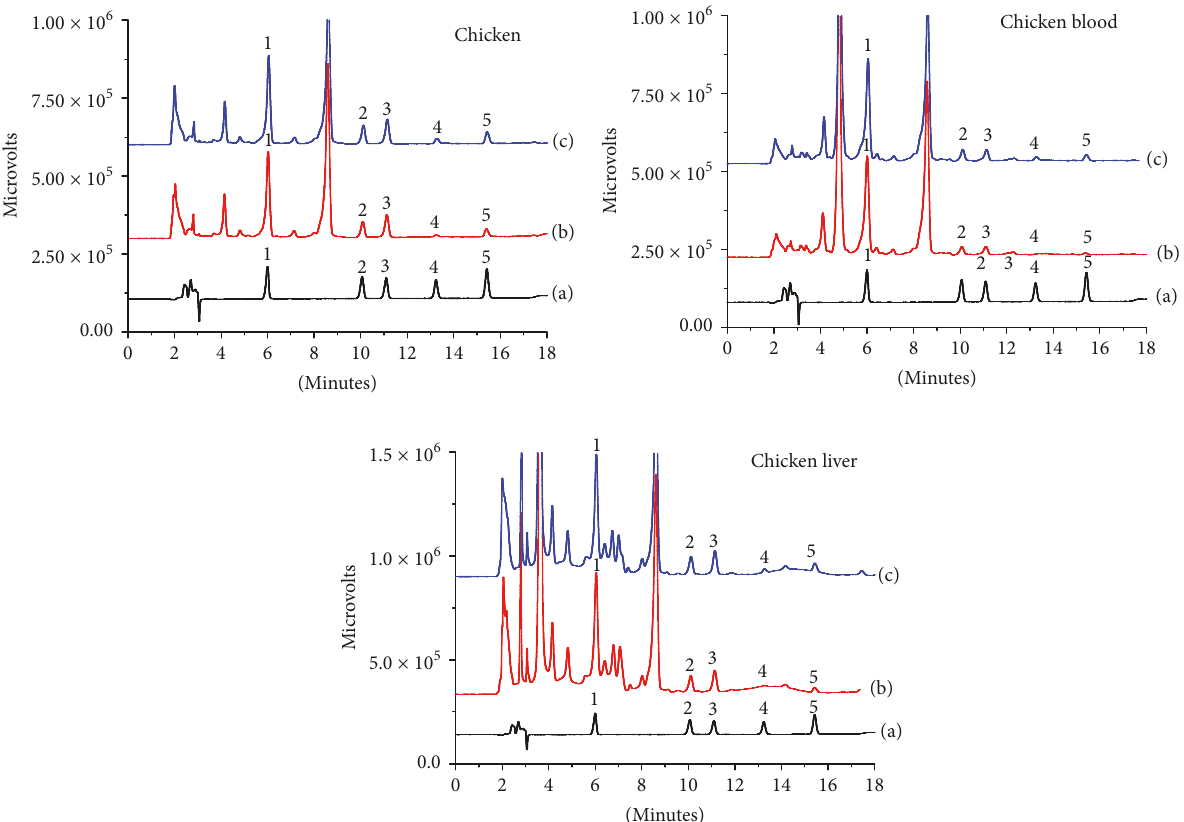
Figure 6: Chromatograms of BMZs in chicken, chicken blood, and chicken liver samples. (a) the standard solution at 1.0 mg/L, (b) a sample solution extracted by G-Fe 3 O 4 MSPE, and (c) 0.8 ng/g of the spiked sample solution extracted by G-Fe 3 O 4 MSPE. The peaks corresponded to the following BMZs: 1. OXF, 2. MEB, 3. FLU, 4. ALB, and 5.